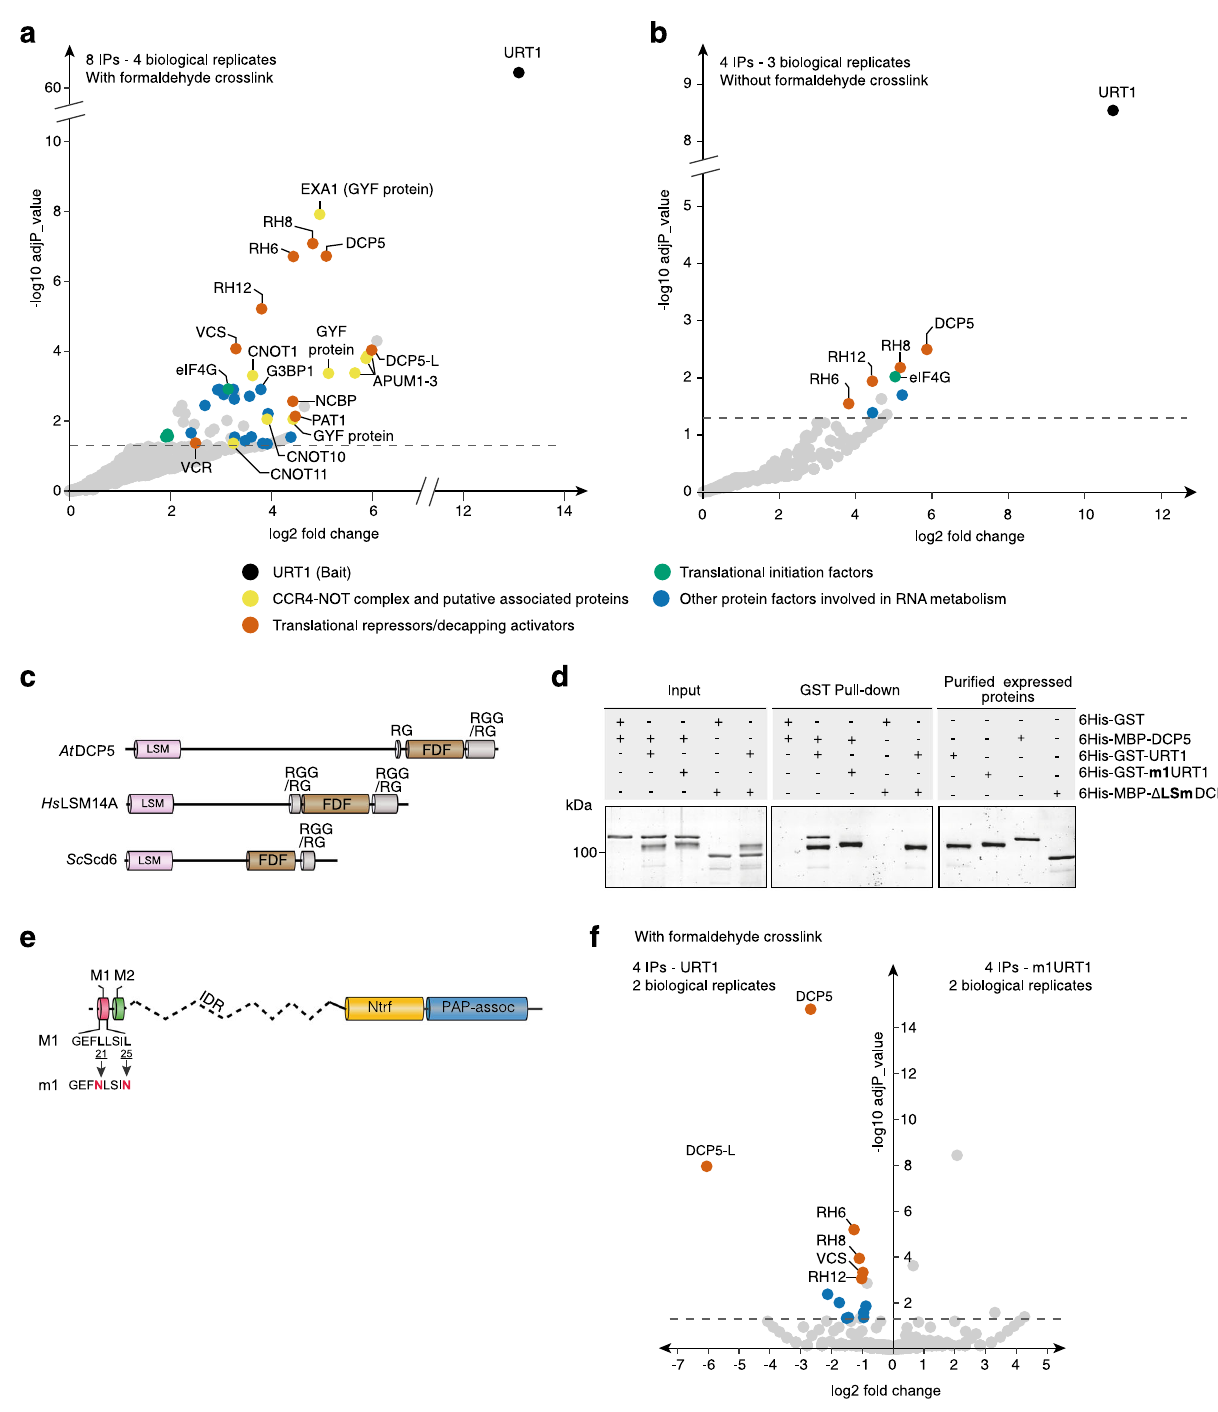
Fig. 2 URT1 co-puri fi es with translational repressors/decapping activators. Enrichment of proteins co-puri fi ed with myc and YFP-tagged URT1 with formaldehyde crosslink ( a ) or without ( b ). The dashed line indicates the threshold above which proteins are signi fi cantly enriched (adjusted p value < 0.05, quasi-likelihood negative binomial generalized log-linear model). c Common domain organization of Arabidopsis ( At ) DCP5 and its human ( Hs ) and yeast ( Sc ) orthologs LSM14A and Scd6, respectively. d In vitro GST pull-down assay showing a direct URT1-DCP5 interaction. Pull-downs were performed in presence of RNase A with the recombinant proteins 6His-GST, 6His-GST-URT1, 6His-MBP-DCP5, 6His-GST-m1URT1, and 6His-MBP- Δ LSmDCP5. Pull- down and input fractions were analyzed by SDS-PAGE and SYPRO Ruby staining. e Diagram illustrating the point mutations in m1URT1 construct. f Volcano plot showing proteins differentially enriched (log2 fold change > 0) or depleted (log2 fold change< 0) in myc-tagged m1URT1 versus myc-tagged URT1 IPs. The dashed line indicates the signi fi cant threshold (adjusted p value < 0.05, quasi-likelihood negative binomial generalized log-linear model). Dot color code is as in a . The source data are available in Supplementary Data 2, at [https://www.ebi.ac.uk/pride/archive/projects/PXD018672] and at [https://